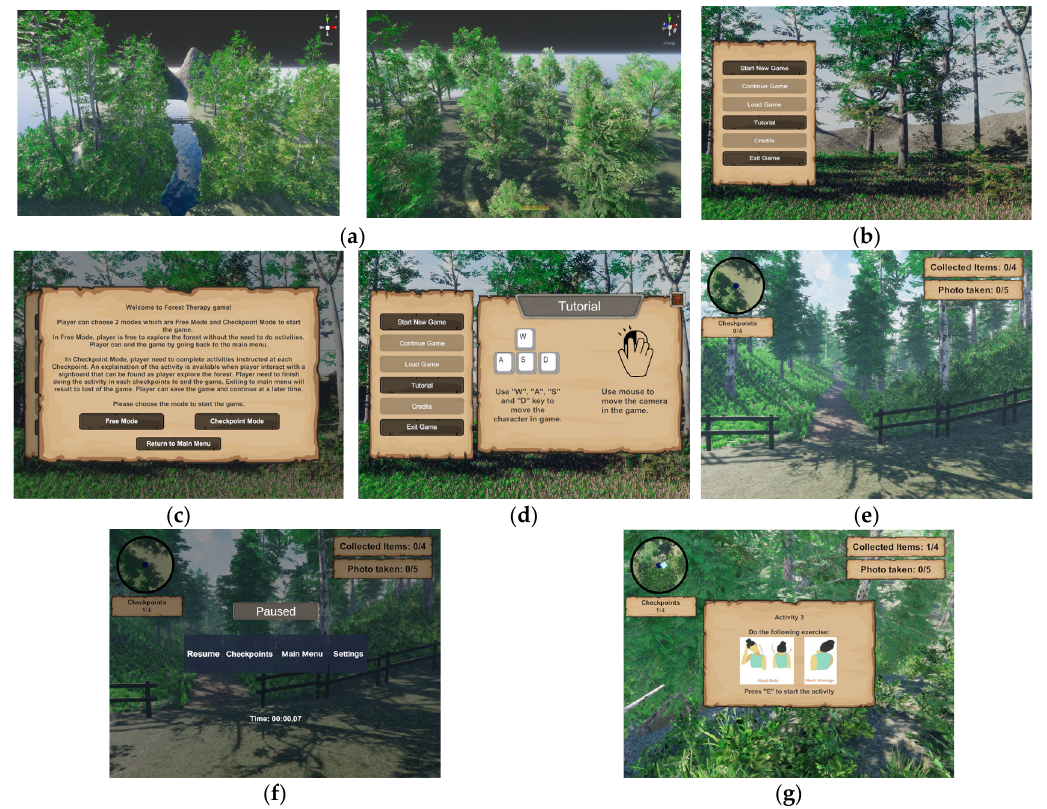
Figure 3. The game interface designs include ( a ) the forest environment, ( b ) the start menu interface, ( c ) the mode selection interface, ( d ) the application tutorial, ( e ) the in-game interface, ( f ) the pause menu interface, and ( g ) the triggered activity dialogue interface.